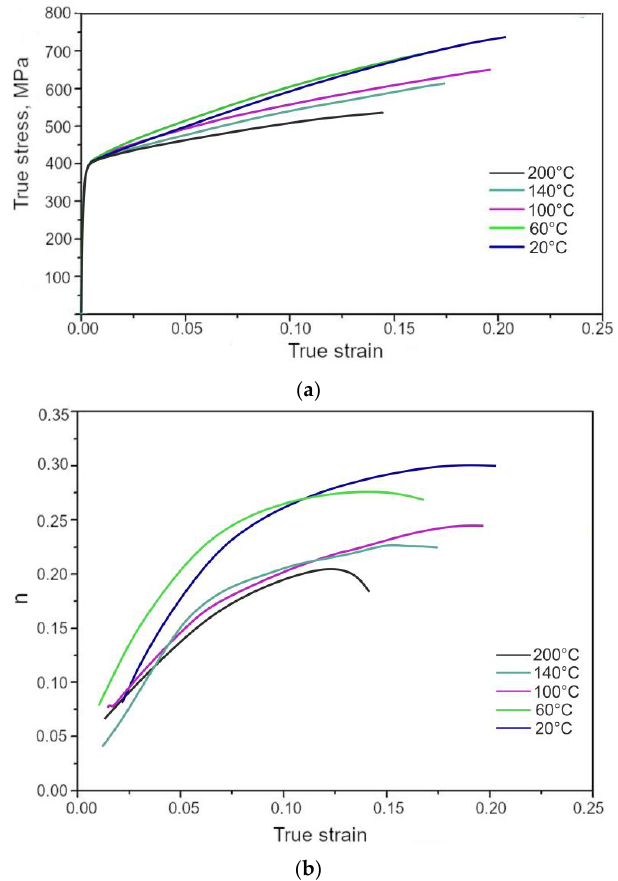
Figure 11. True stress vs. true strain ( a ) and work hardening exponent (n) changes ( b ) at different deformation temperatures. deformation